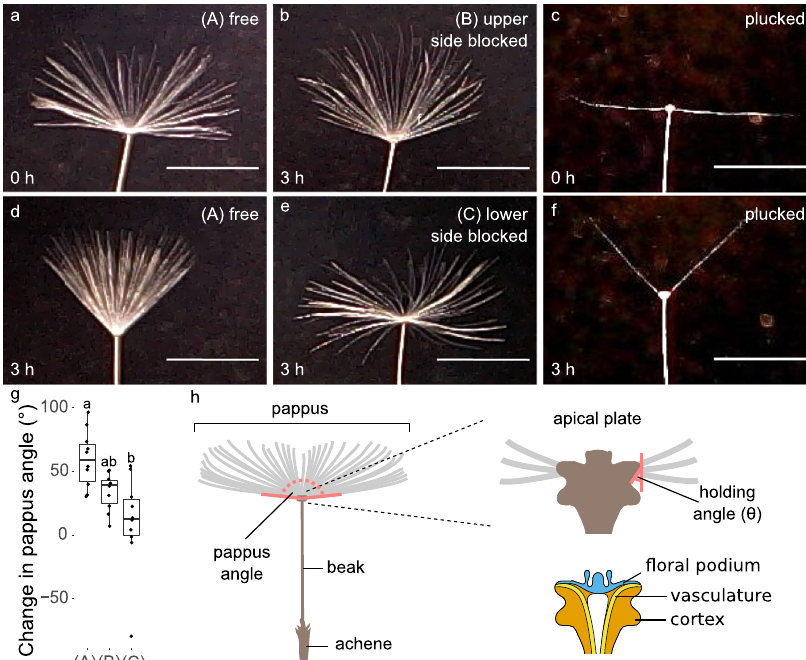
Fig. 1 The apical plate is required for pappus morphing. a , b , d , e Apical plate blocking experiments showing a a sample before hydration, and b , d , e 3 h after wetting. a and d have no resin applied, b has resin applied to the upper side of the apical plate, e has resin applied to the lower side of the apical plate. Scale bars are 5 mm. Images in a and d are of the same sample as each other, images b and e are different samples from all others shown here. c , f Effect of removing hairs on pappus morphing. c A sample before hydration with all but two opposite hairs removed, f The same sample as in c 3 h after hydration. Scale bars are 5 mm and images are representative of n = 10 biologically independent samples for each treatment. g The change in pappus angle (between outermost hairs) between dry and wet conditions for apical plate blocking experiment. A, B, and C represent the ‘ free ’ , ‘ upper side blocked ’ , and ‘ lower side blocked ’ treatments respectively as indicated in panels a , b , d and e . n = 10 biologically independent samples per treatment, ANOVA F (2,27) = 8.63, p = 0.0013, η 2 = 0.39. Different letters above two boxplots indicate statistically signi fi cant differences between the two corresponding conditions with a two-sided Tukey ’ s HSD at p < 0.001. The centre line is the median, hinges indicate fi rst and third quartiles, and whiskers extend to largest value no further than 1.5 times the interquartile range. h Illustrates the morphology of the diaspore, location of the apical plate, and a cross-sectional view of the apical plate indicating some internal structures. Red lines indicate the pappus angle, and holding angle, θ